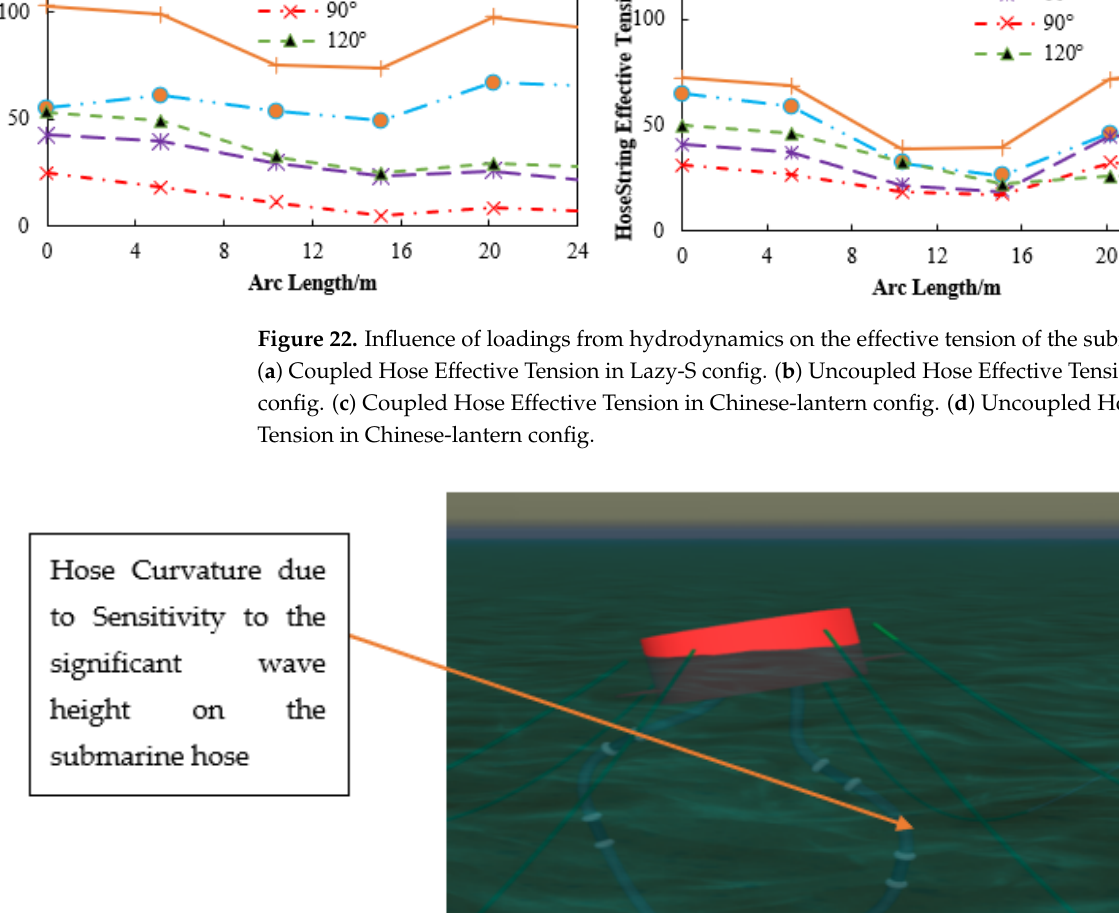
Figure 24. Influence of hydrodynamic loads on the bending moment of the submarine hose. ( a ) Coupled model for hose bending moment in Lazy-S config. ( b ) Uncoupled hose bending moment in Lazy-S config. ( c ) Coupled hose bending moment in Chinese-lantern config. ( d ) Uncoupled hose bending moment in Chinese-lantern config. 4.1.5. Results of DAF of hose ( DAF hose ) Sensitivity The sensitivity studies on the DAF Hose for marine hoses are calculated by considering one submarine hose-string, Hose1, as presented in Figure 25a–f. The comparisons of the curvature profiles for Lazy-S and Chinese-lantern configurations showing the cases in- cluding the hydrodynamic loads and excluding the hydrodynamic loads are shown in Figure 25a,b by the curvature DAF Hose . The behavior of submarine hoses is subject to the buoyancy of the hose and the attached floats. However, with some flexibility in the hose- string under waves and current loadings, the hose-string is also designed to be resistant